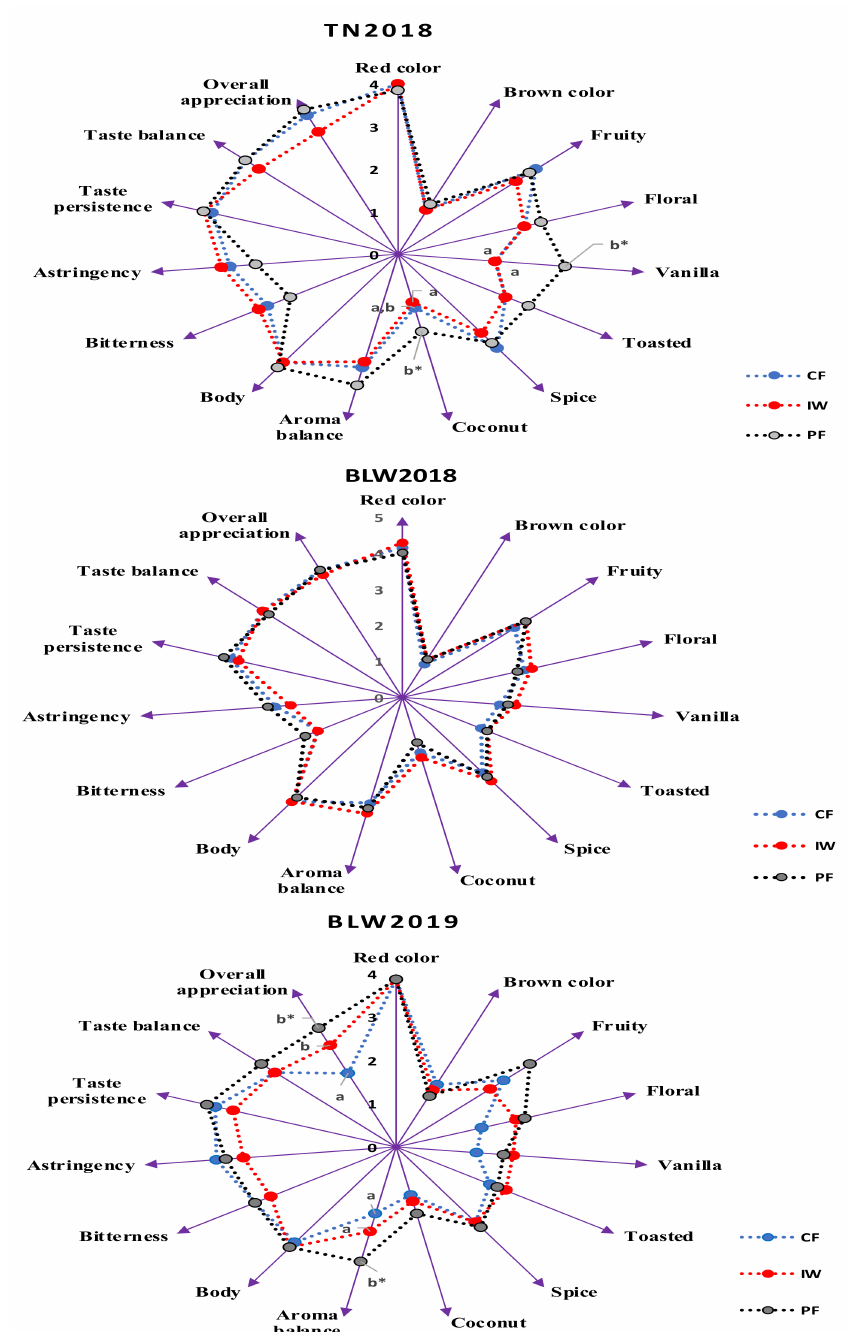
Figure 5. The impact of the two different filtration techniques on the sensorial profiles of the three red wines studied. TN2018, the red wine produced from the Touriga Nacional grape variety in 2018; BLW2018, the red wine produced from a blend containing Touriga Nacional, Tinta Roriz, Alfrocheiro and Jaen grape varieties in 2018; BLW2019, the red wine produced from a blend containing Baga and Tinta Pinheira grape varieties in 2019; IW, initial wine (unfiltered); CF, cross-flow microfiltration; PF, membrane plate filtration. * The sensory parameters where there are significant differences between the wines and in which values with the same letter are not significantly different (Tukey test, p <